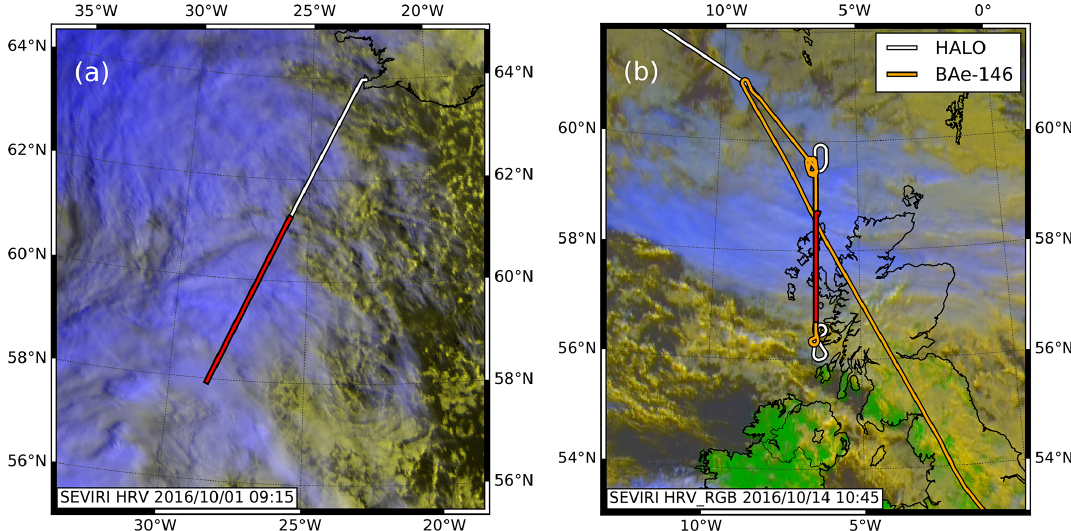
Figure 6. (a) SEVIRI satellite image of the case discussed in Fig. 7 (red section), where HALO (white) measured the cirrus outflow of a WCB on 1 October 2016 in a region south of Iceland. (b) SEVIRI satellite image of the case discussed in Fig. 8. On 14 October 2016, HALO (white) and the FAAM BAe-146 (orange) research aircraft flew a coordinated flight leg (red section) over ice clouds within an occluded front west of the Scottish Highlands. © 2020